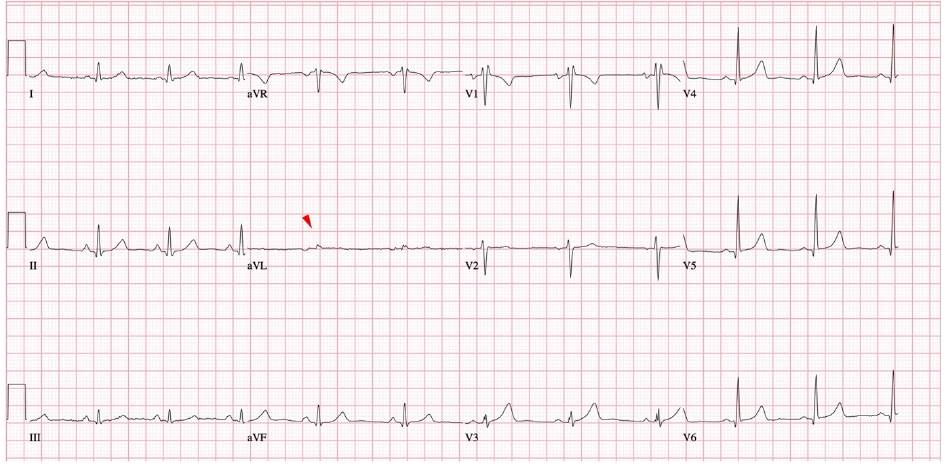
Figure 5. Isolated very low QRS voltage in frontal plane leads (red